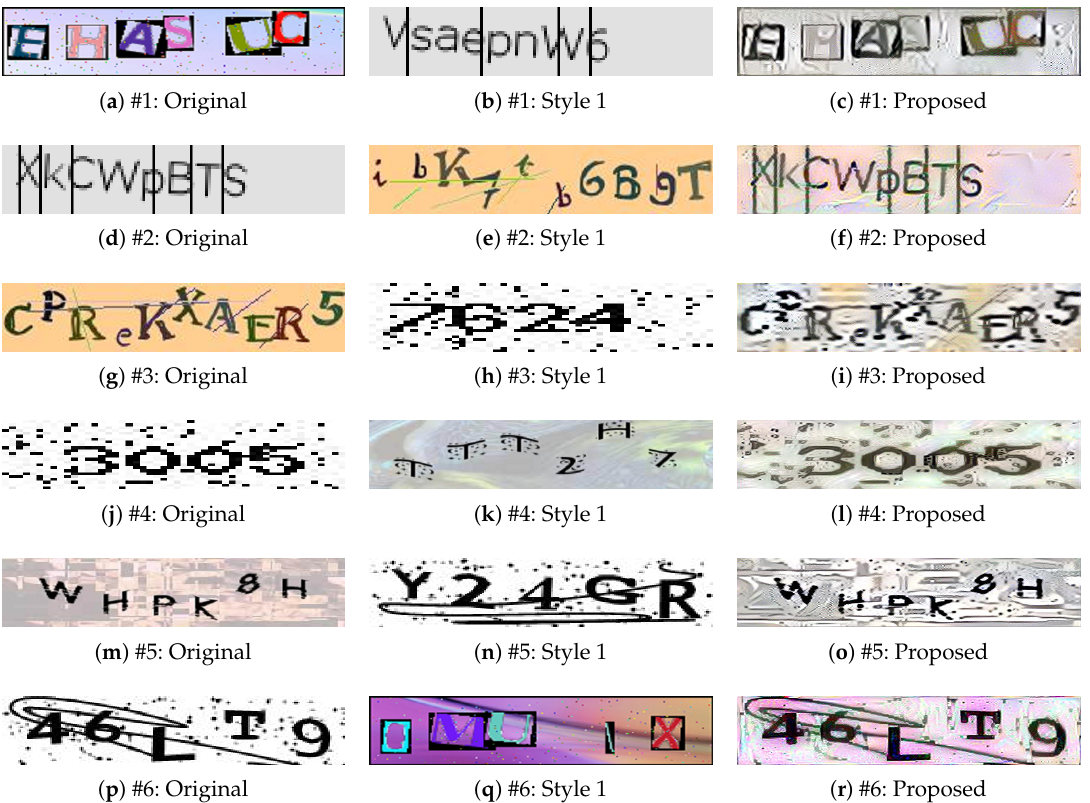
Figure 4. Examples of style-plugged CAPTCHAs formed using one style image. “Original" is the original image, “Style 1" is the second image, and “Proposed" is the style-plugged-CAPTCHA image.